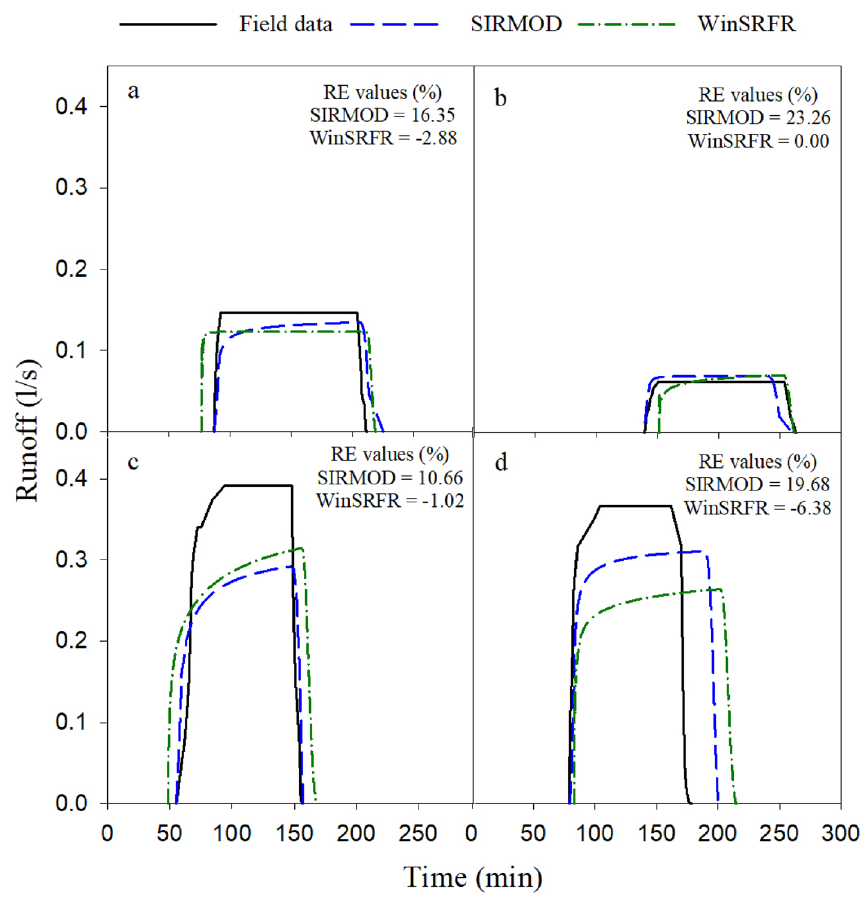
Figure 6. Comparison of the measured and simulated runoff under surge irrigation ( a . Q 1 L 1 R 0.5 , b . Q 1 L 2 R 0.5 , c . Q